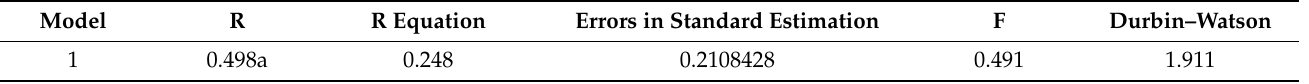
Table 6. Model summary.